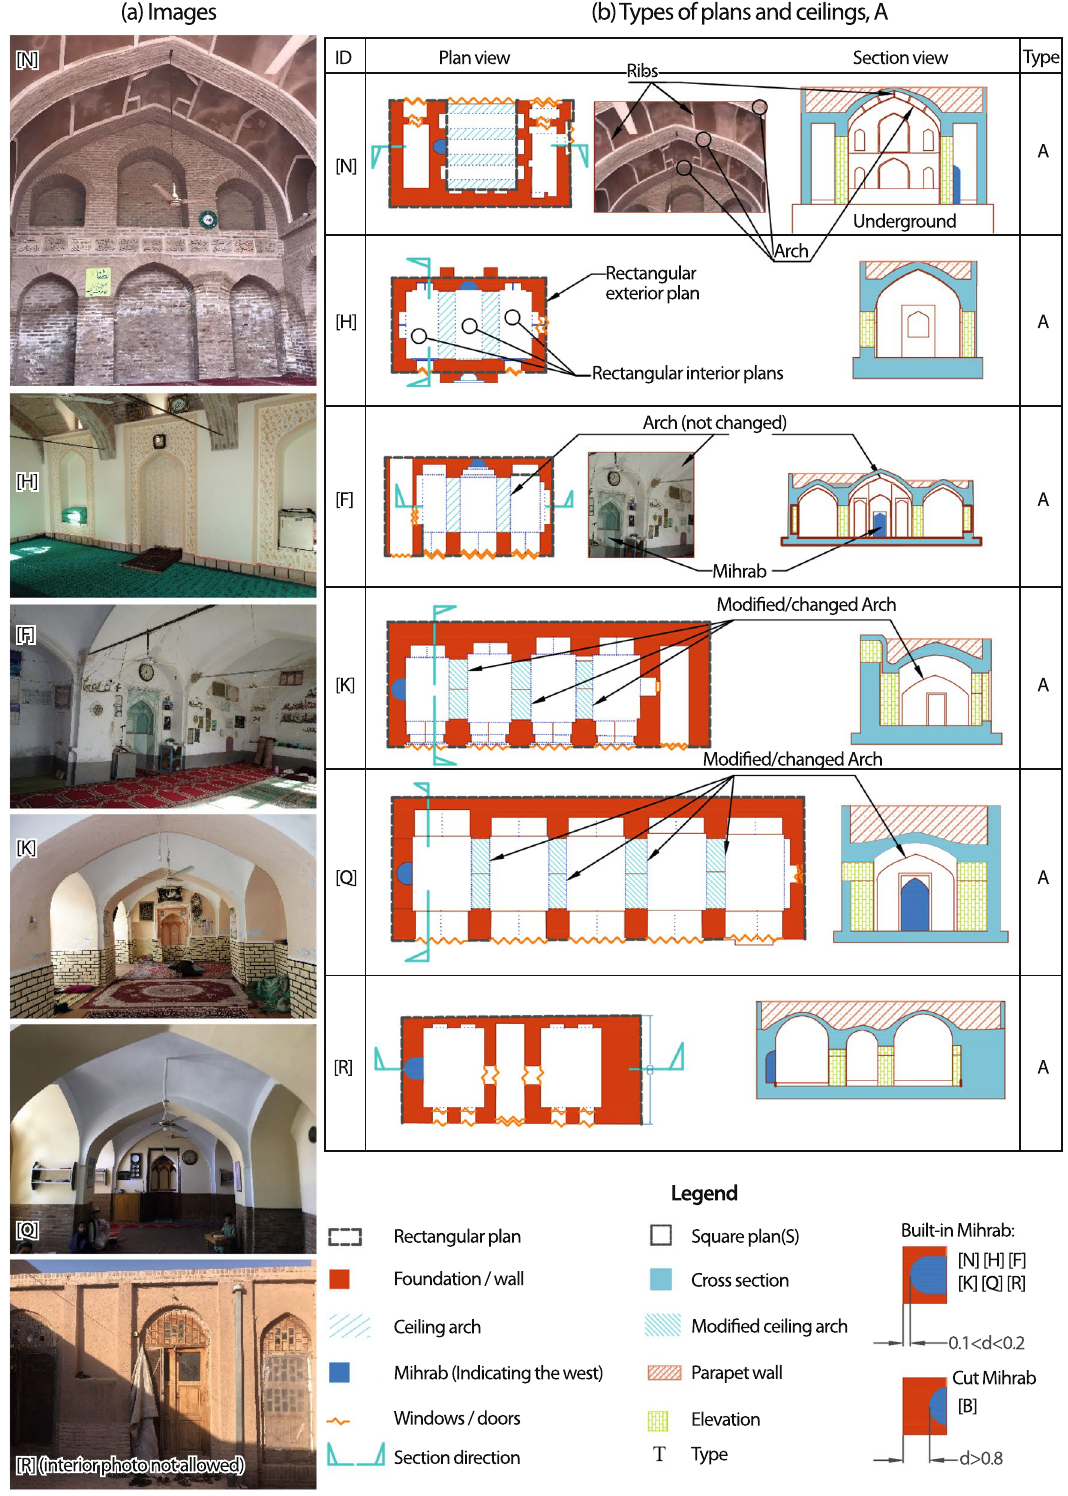
Fig. 4 Architectural classification of mosques, Type A. 2021 (Source: the